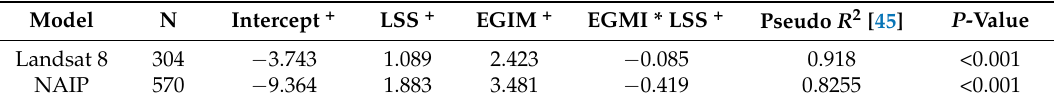
Figure 10. Observed versus predicted proportion of variance explained ( R 2 ) for co-registration errors associated with Landsat 8 and NAIP imagery and virtual imagery, given various sample unit sizes, measures of spatial correlation, and top-fitting beta regression models. The gray diagonal line is a one-to-one reference line.